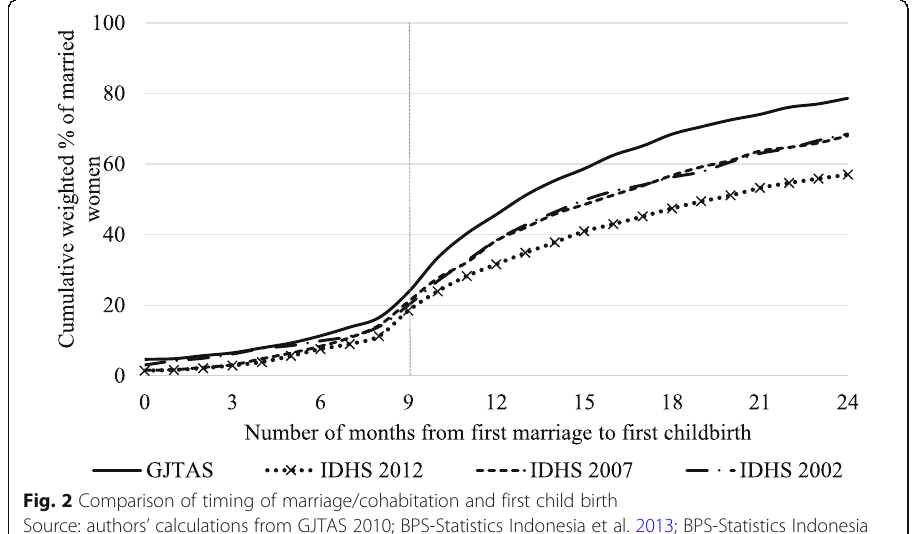
Fig. 2 Comparison of timing of marriage/cohabitation and first child birth Source: authors ’ calculations from GJTAS 2010; BPS-Statistics Indonesia et al. 2013; BPS-Statistics Indonesia and Macro International 2008; BPS-Statistics Indonesia and ORC Macro